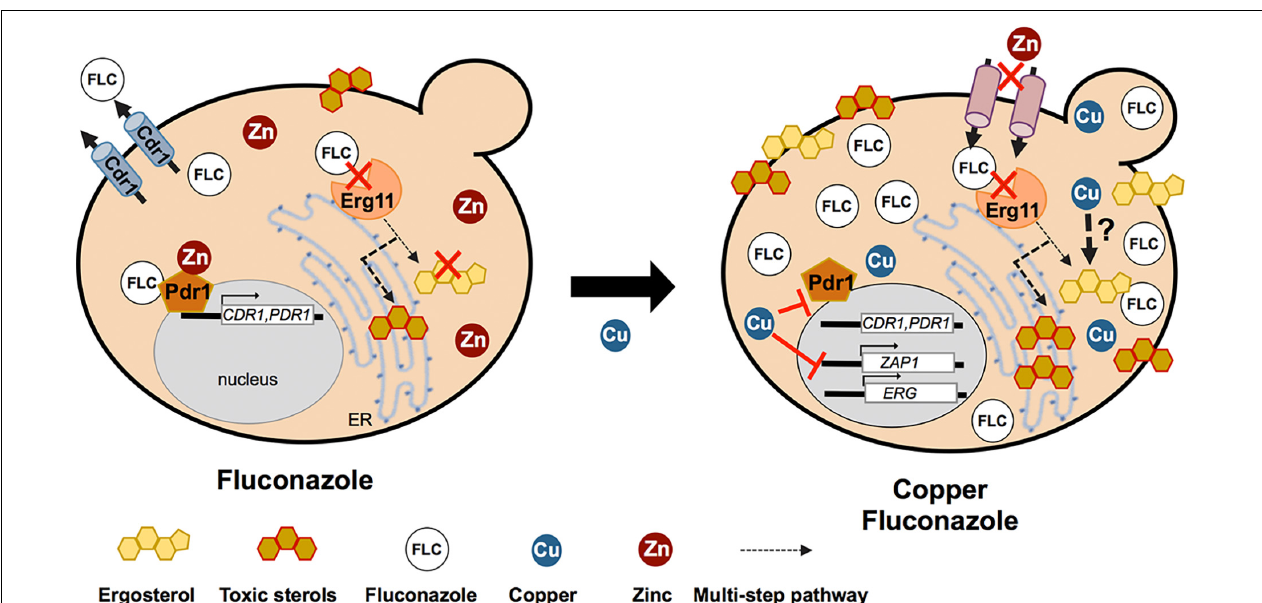
FIGURE 9 | Schematic figure depicting the molecular mechanisms underlying copper and fluconazole synergism. Pdr1 binds to fluconazole (FLC) and activates the expression of genes such as CDR1 , promoting fluconazole efflux. FLC inhibits Erg11, which leads to blockade of the ergosterol biosynthesis pathway and activation of an alternative sterol pathway that culminate in ergosterol depletion and accumulation of toxic sterols. Copper (Cu) decreases the transactivation activity of Pdr1, rendering cells unable to activate CDR1 and detoxify FLC. The combination of Cu and FLC also leads to a greater accumulation of toxic sterol intermediates and a consistent downregulation of several genes of the ergosterol pathway ( ERG genes). However, copper appears to be able to stimulate ergosterol biosynthesis through an as yet unknown mechanism. In addition, Cu and FLC exert a strong inhibition on the expression of ZAP1 , which causes zinc depletion, further contributing to cellular